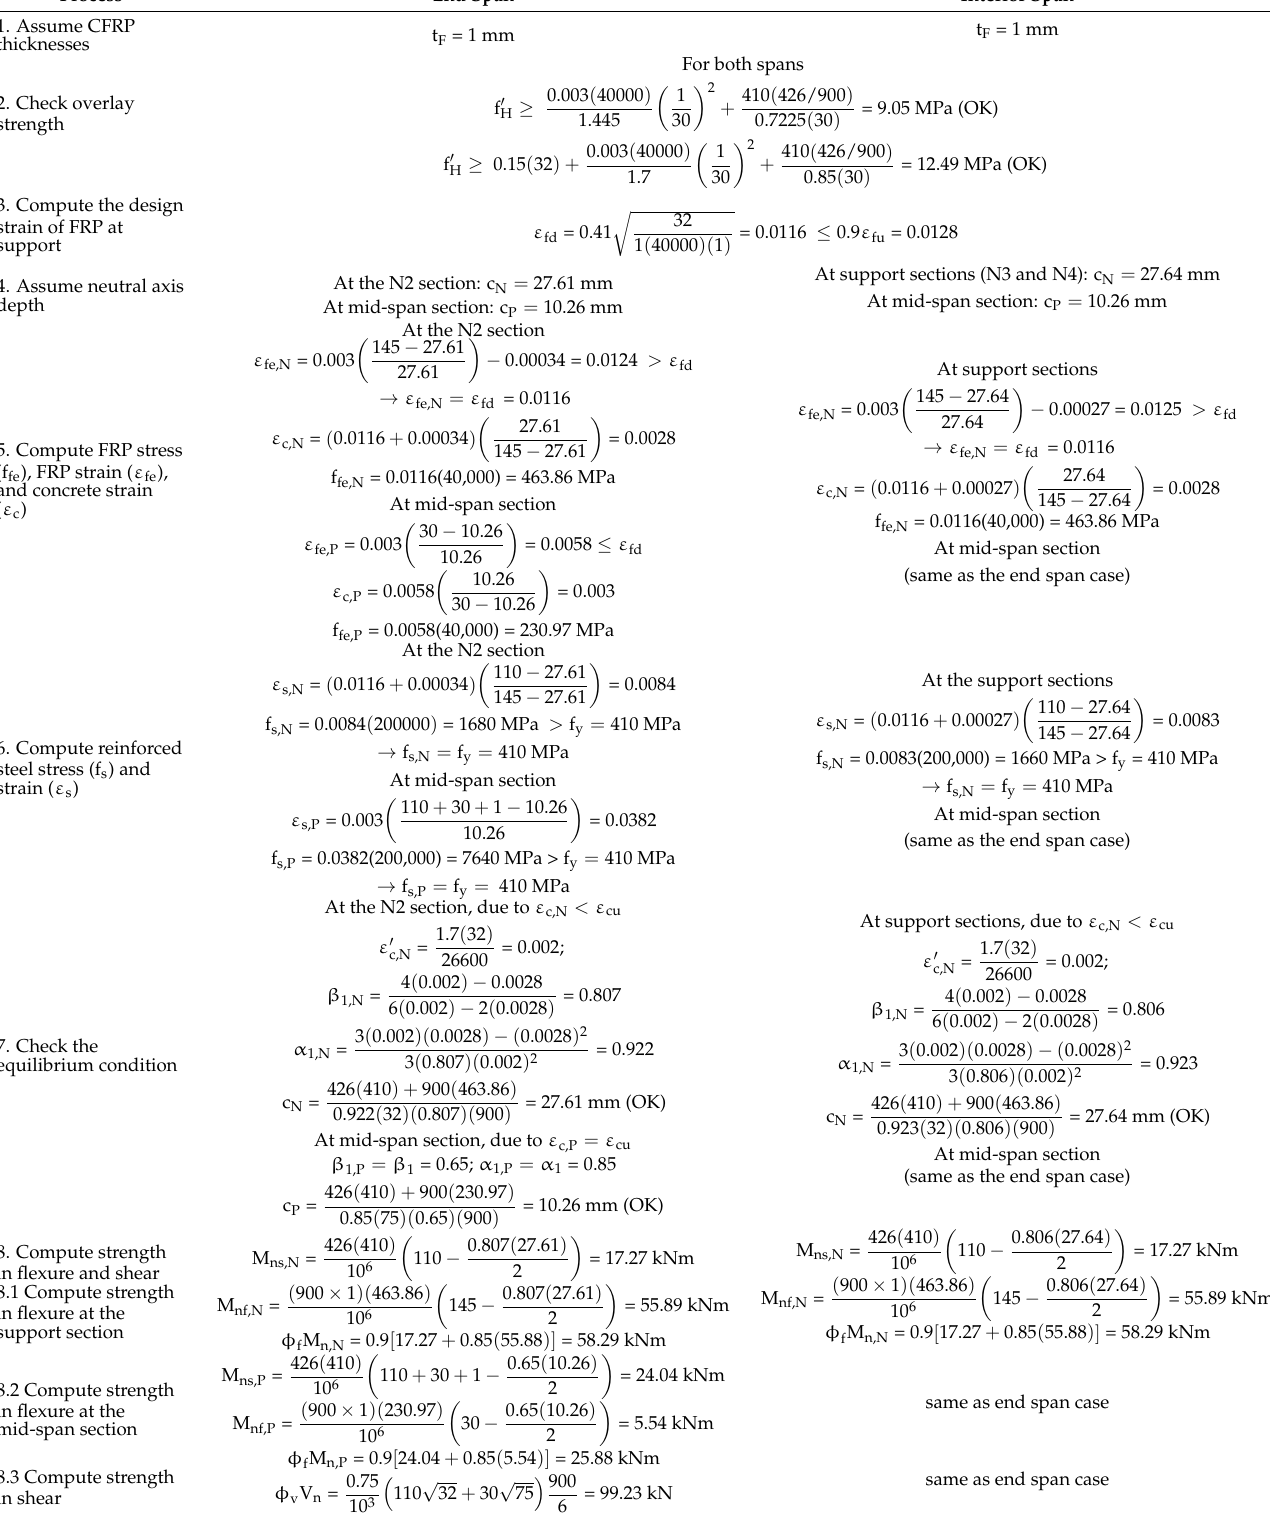
Table 6. Analysis of the retrofitted slab considering brittle-failure